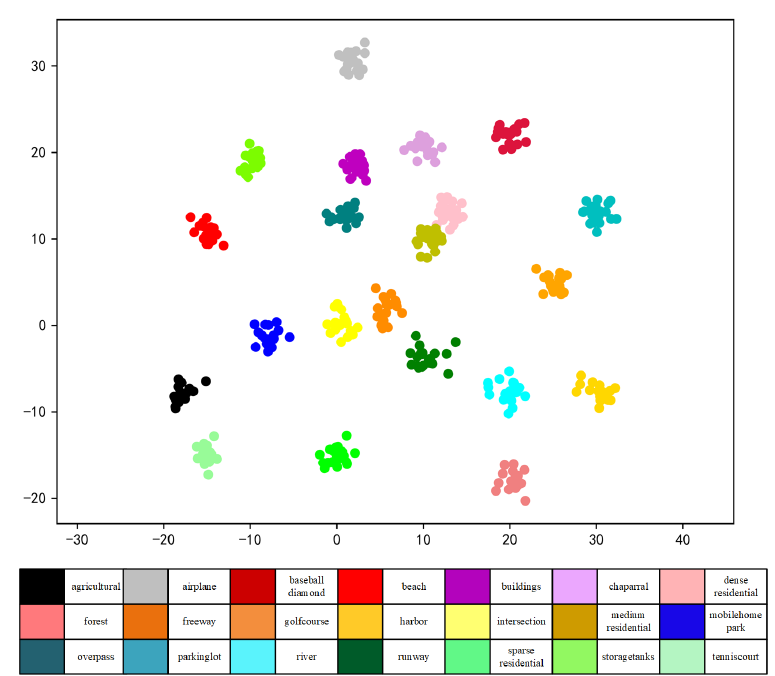
Figure 19. The T-SNE algorithm visualization results of our model on UCM